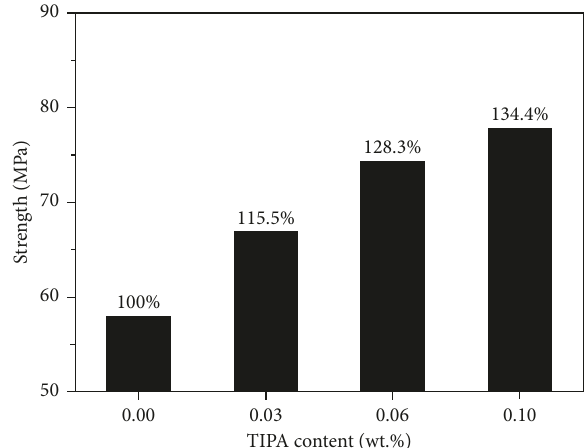
Figure 5: Effect of TIPA on compressive strength of 60d.